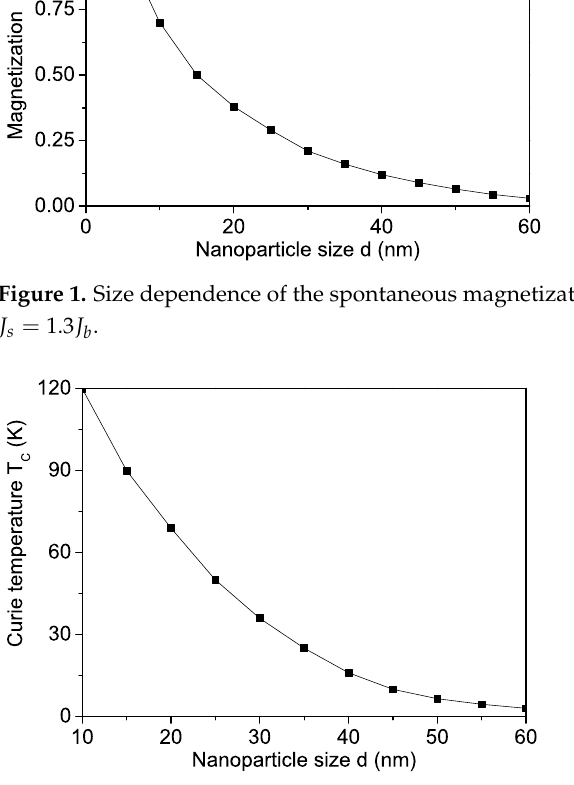
Figure 2. Size dependence of the Curie temperature T C for a pure MgO NP, J s = 1.3 J b